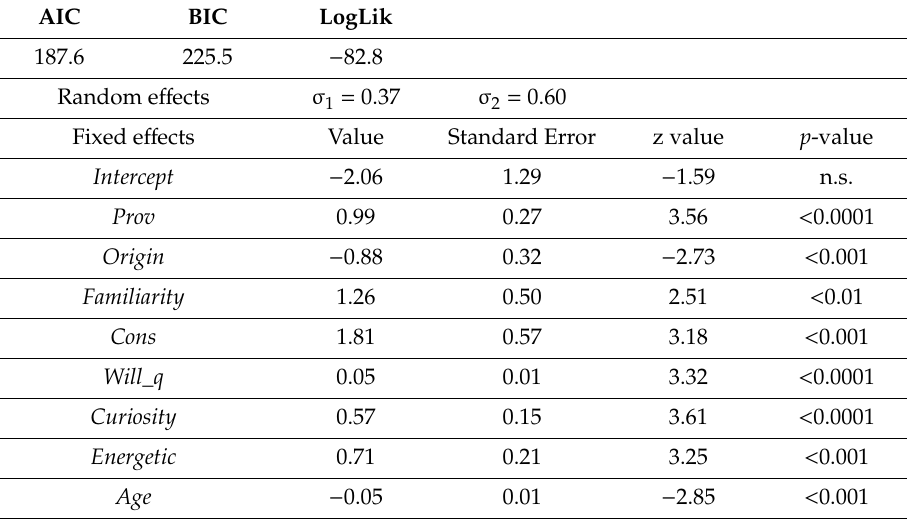
Table 3. Parametric estimation results for the intermediate model Equation (2). AIC